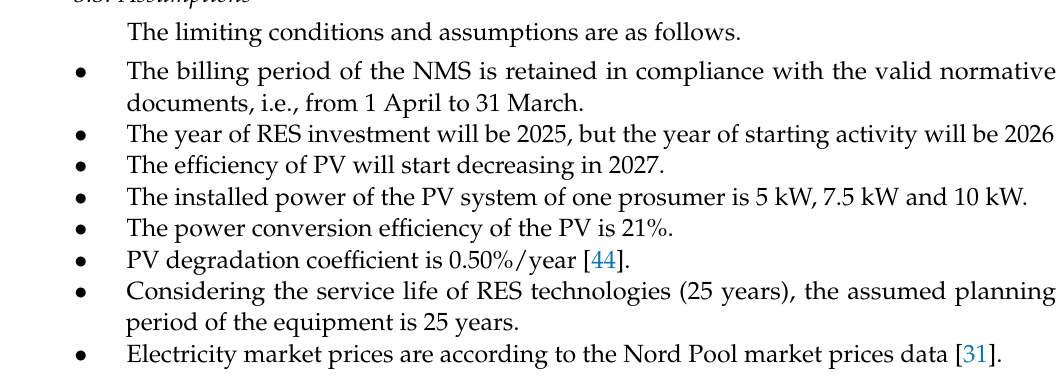
” is a selected (cid:8)